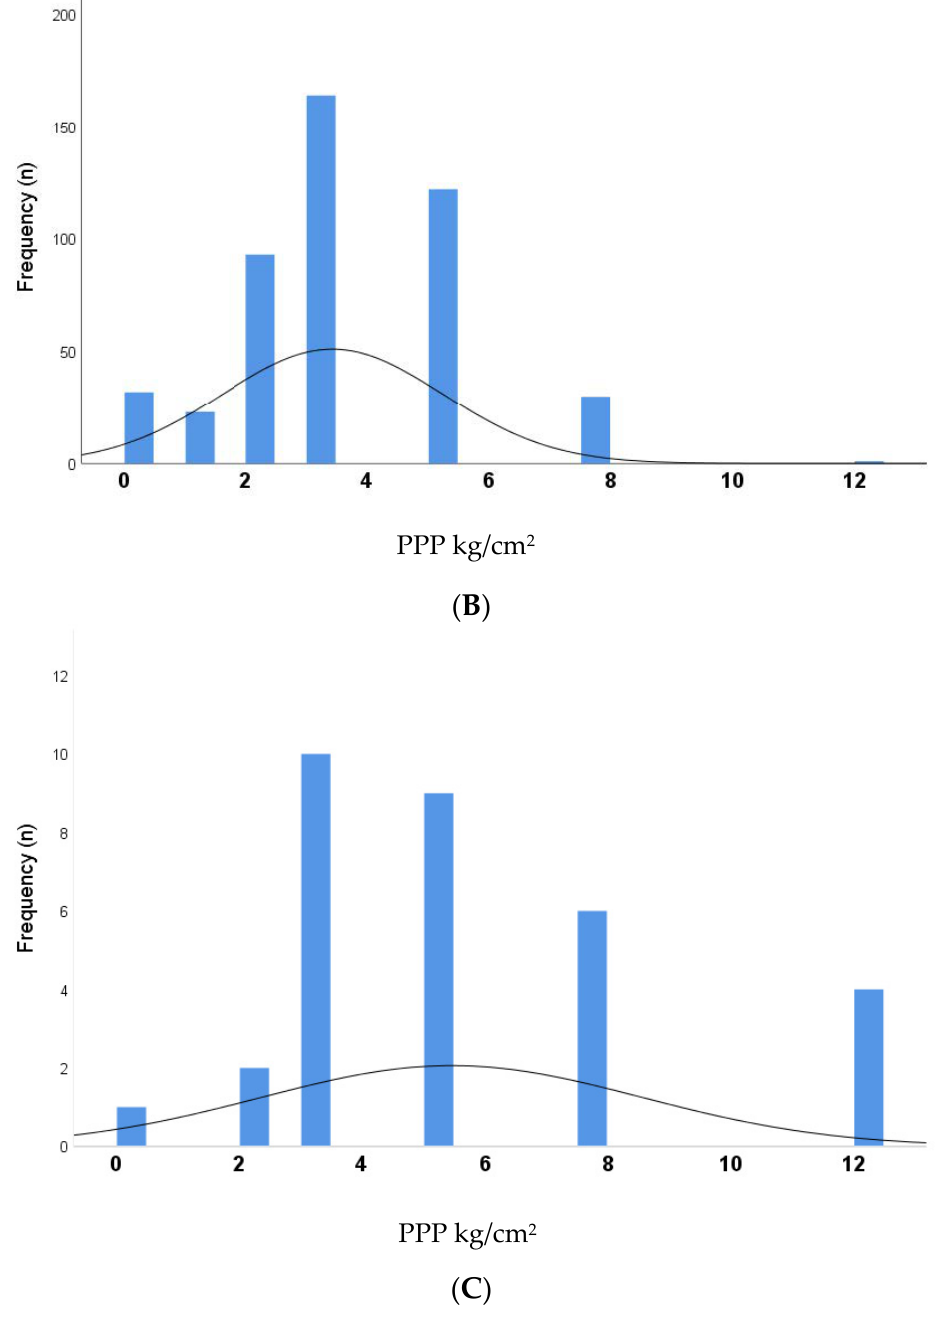
Figure 1. Distribution curves for PPP (peak plantar pressure) values at specific plantar sites ( n = 792) for all participants ( n = 33); split into 3 sub-groups for analysis: ( A ) PPP values at healthy control sites ( n = 288); ( B ) PPP values at diabetes sites without DFU history ( n = 472); ( C ) PPP values at diabetes sites with DFU history ( n = 32). Median (IQR) PPP for the groups were: a) control sites = 2 (2–3.25) kg/cm 2 ; diabetes sites without DFU history = 3.25 (2–5) kg/cm 2 ; diabetes sites with DFU history = 5 (3.25–7.5) kg/cm 2 respectively and were significantly different ( p < 0.0001).